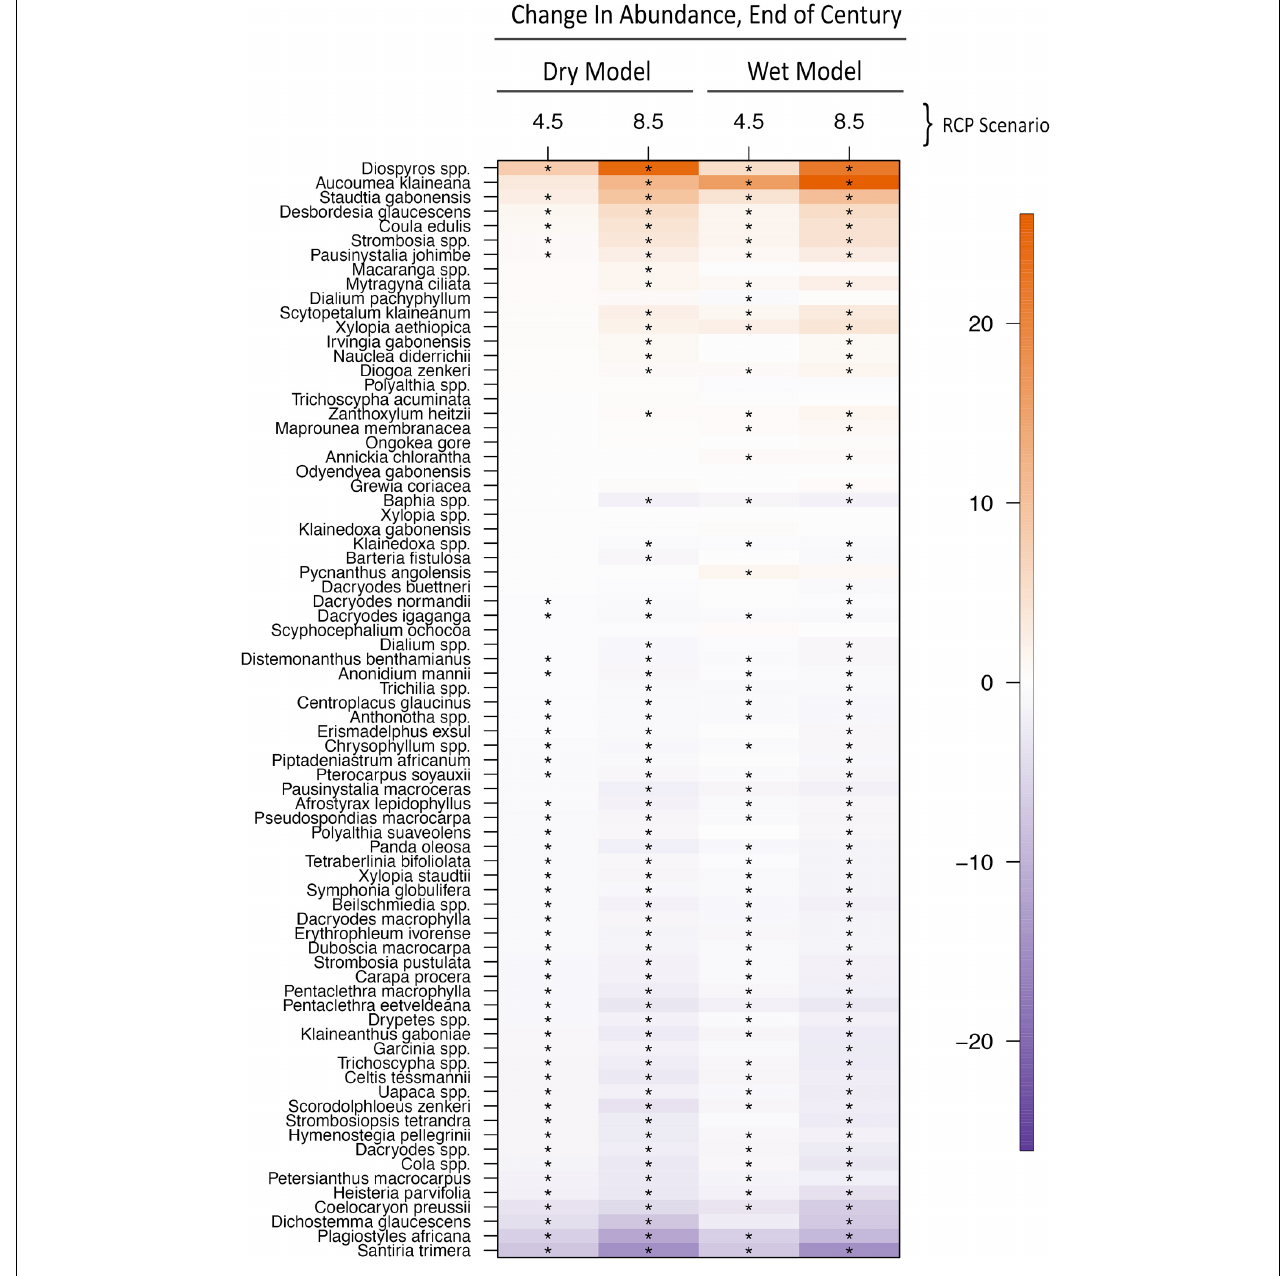
FIGURE 5 | Predicted change in abundance for each tree species (y-axis) by the end of the century for RCP 4.5 and RCP 8.5 in both the “wet” and “dry” model ensembles (x-axis). Box colors correspond to estimated changes in species abundance. “*” symbol in box denotes species-model predictions that do not overlap with